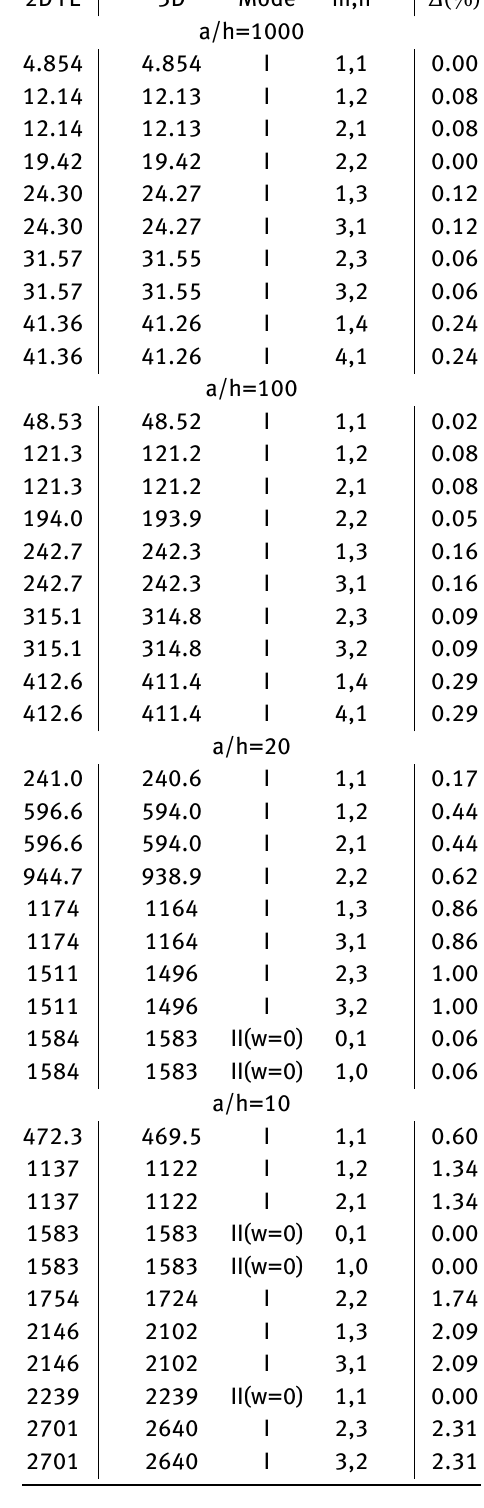
Table 8: First benchmark, simply supported plate made of alu- minium alloy with thickness ratios a/h=1000, a/h=100, a/h=20 and a/h=10. First ten frequencies in Hz, comparison between the present 3D exact solution and the 2D FE solution via Nastran. The error is calculated as ∆ (%) = FE −3 D × 100 3 D